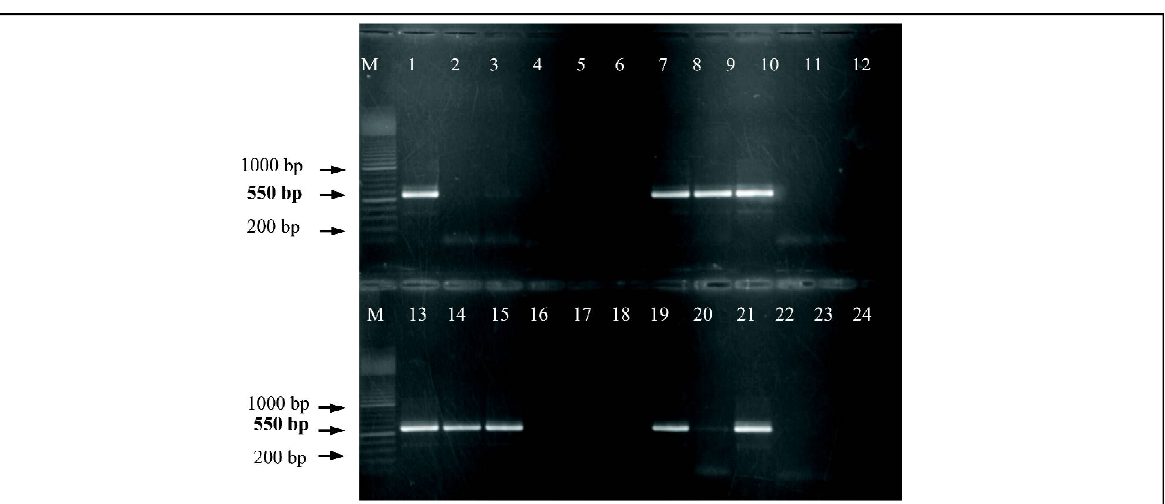
Figure 3: RT-PCR products of MCMV in weed samples tested after mechanical inoculation. Lane M: 100 bp DNA marker; lanes 1 = Positive control (maize), 2 = Amaranthus dubius, 3 = Bracharia brizantha, 4 =